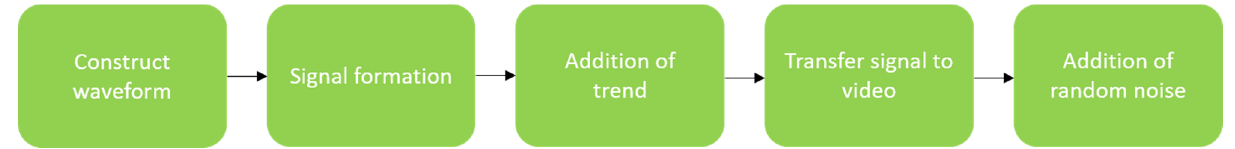
Figure 9. Process of generating synthetic data.